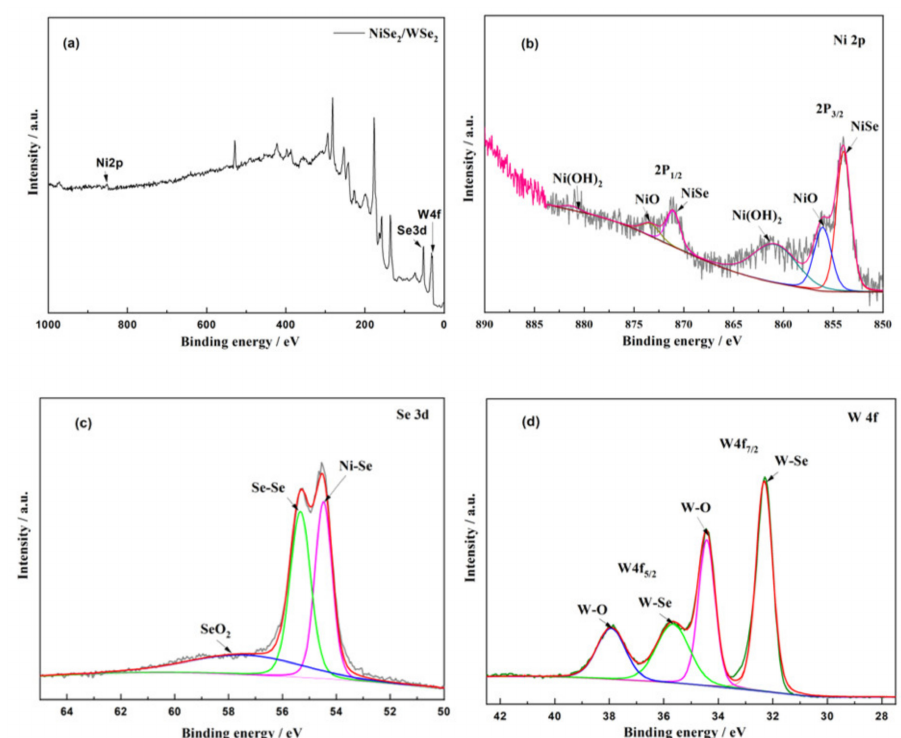
Figure 4. The full XPS spectra of ( a ) NiSe 2 / WSe 2 , ( b ) high-resolution XPS spectra of Ni2p, ( c ) Se3d, ( d )